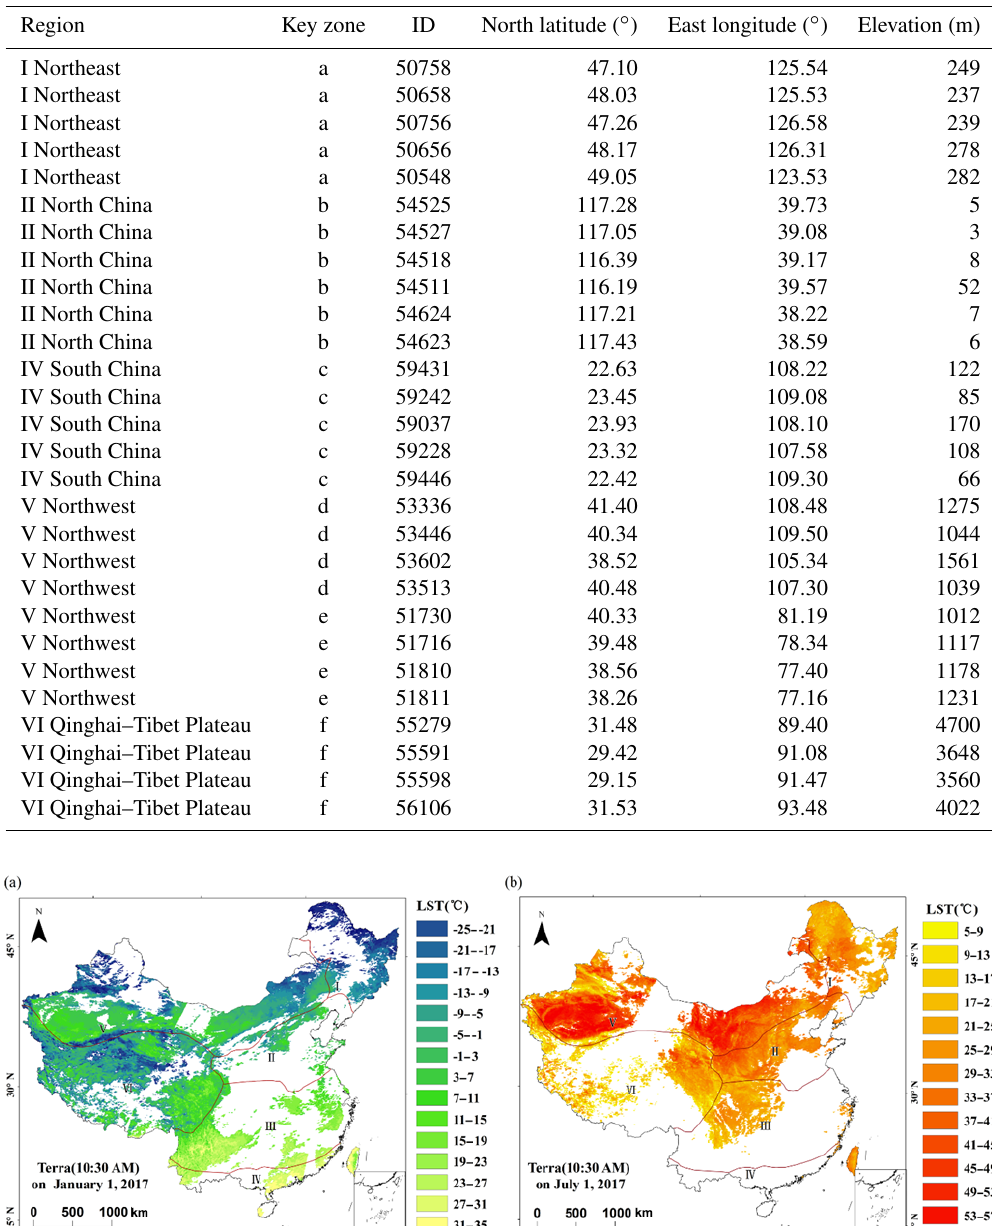
Table 1. Basic information for some of the meteorological stations in key zones.